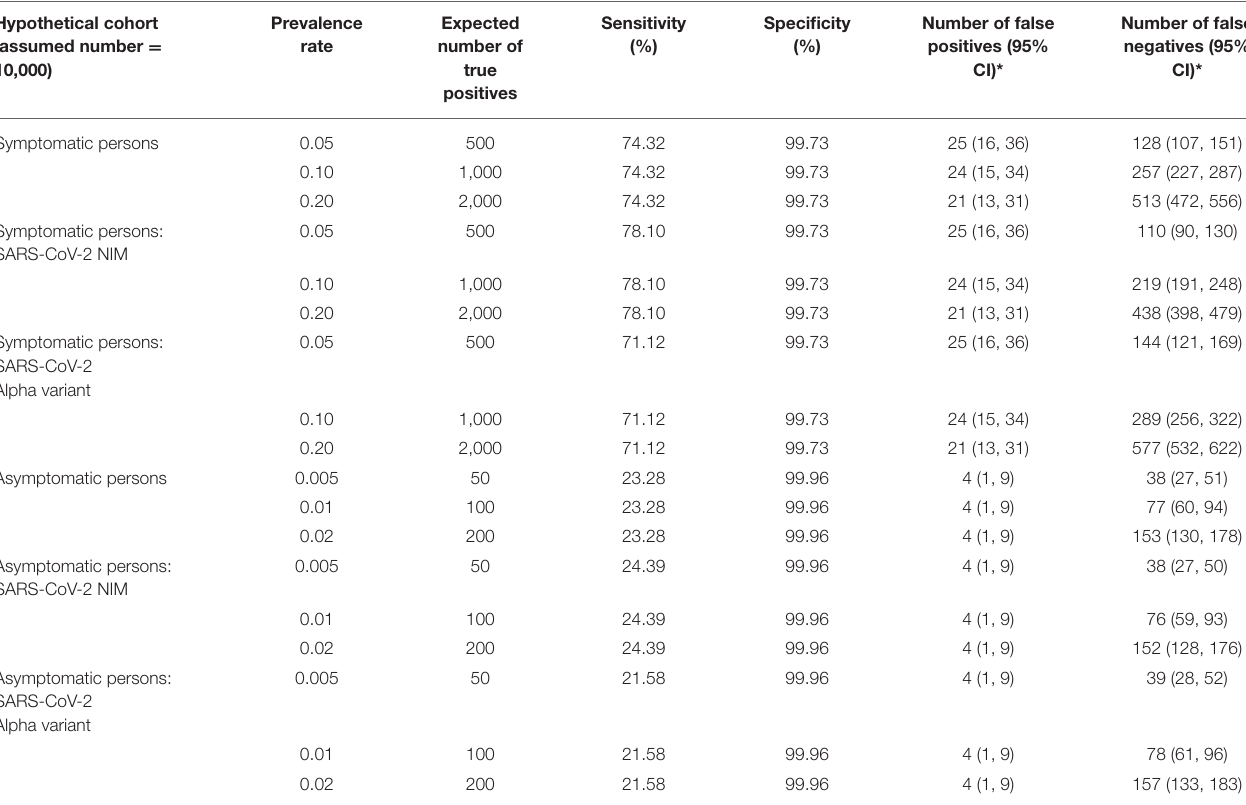
TABLE 4B | Number of false-positive and false-negative results in a hypothetical cohort of 10 000 people tested with the Abbott –RDT. Hypothetical cohort (assumed number =